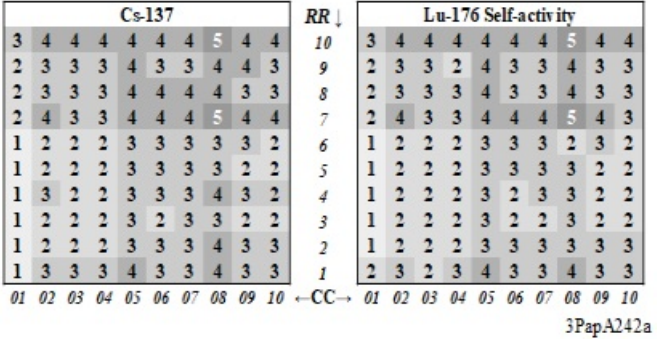
Figure 9. Array maps representing the crystal-pixel’s Fsym values by clusters from Cs-137 ( left ) and Lu-176 self-activity ( right ) data. Fsym bin-sizes values of 3.6-, and 3.2-mm were used, respectively. The locations of pixels in the array were described by the RRCC codes.